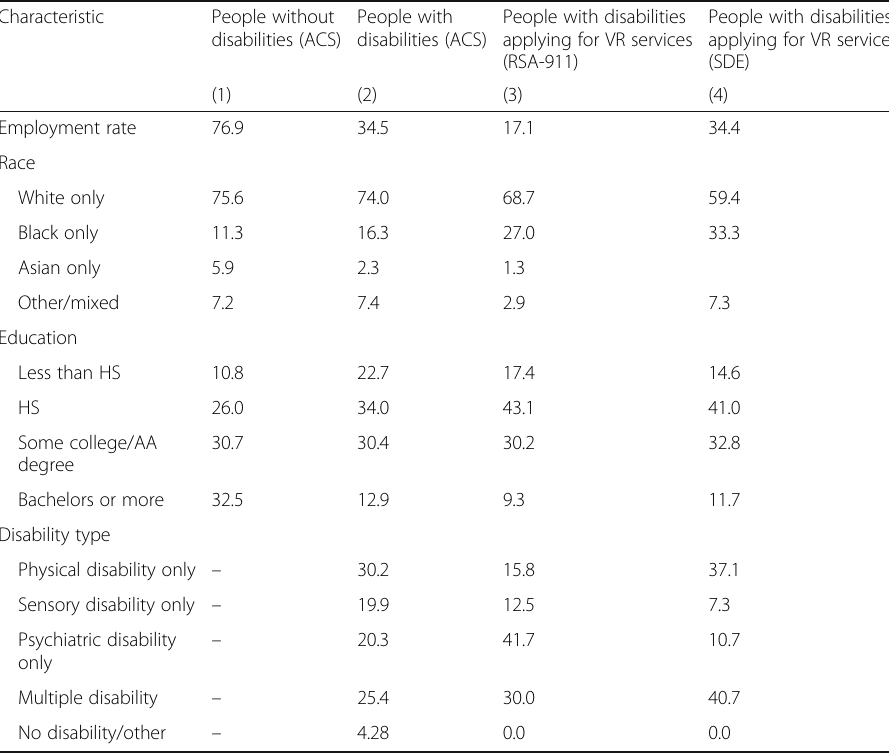
Table 1 Individual characteristics of people with and without disabilities